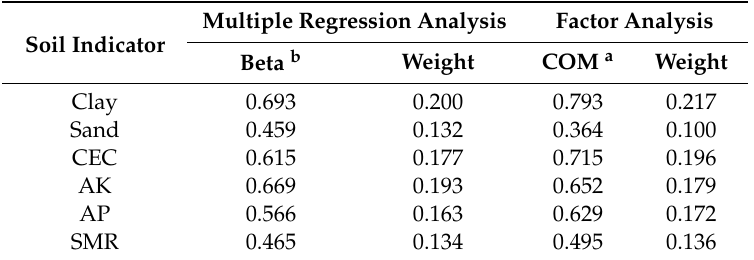
Table 5. Weights values of each soil property in the MDS methods that were assigned using multiple linear regression (MLR) analysis and factor analysis